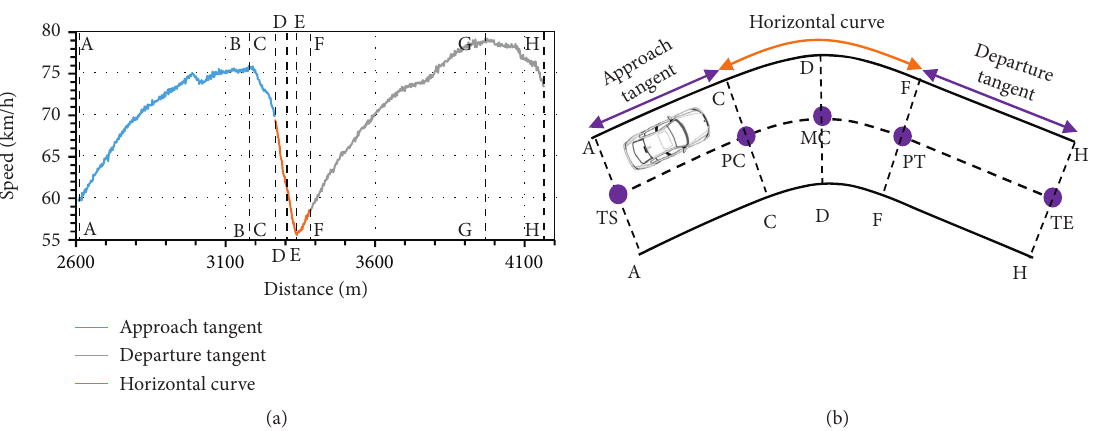
Figure 2: (a) Speed profile segmented for approach/departure tangent and horizontal curve and (b) representation of approach tangent, horizontal curve, and departure